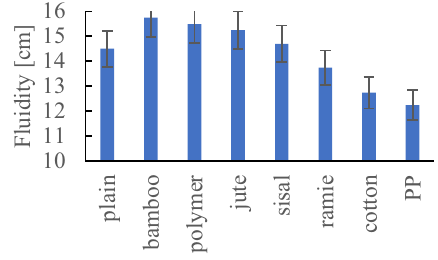
Figure 13. Results of fluidity